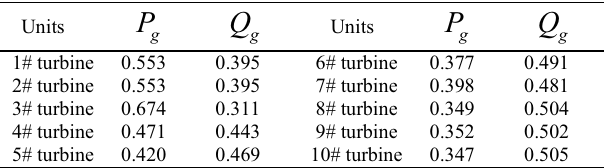
Table 6. Active power and reactive power allocation results